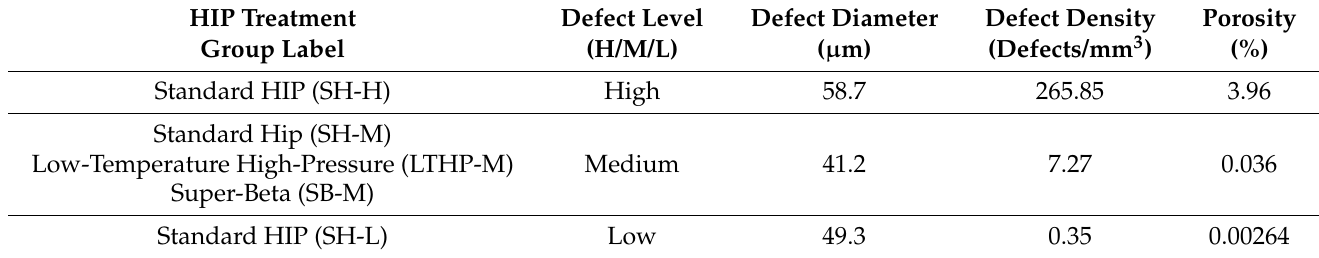
Table 3. Quantification of the initial defect populations measured via X-ray CT. Note: groups SH-M, SB-M, and LTHP-M were taken from the same build using identical fabrication parameters, and thus contained similar average defect